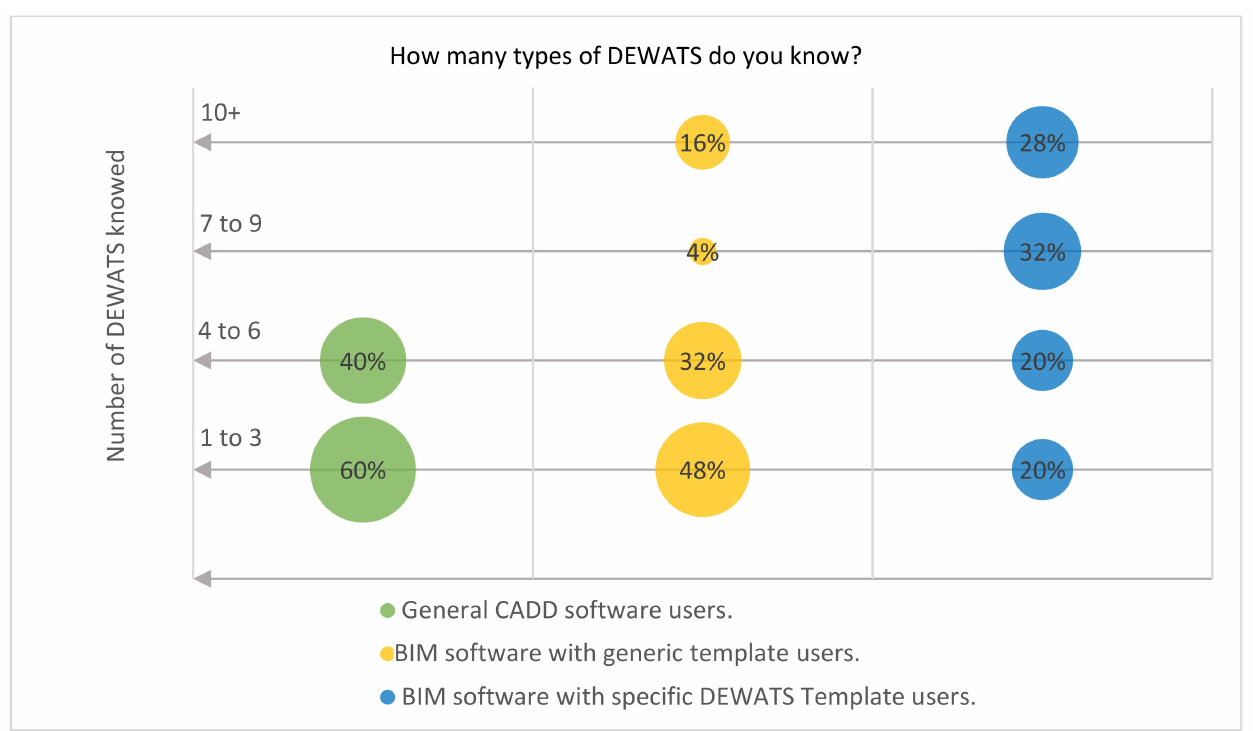
Figure 4. Answers to the second question. Source: authors (2020).